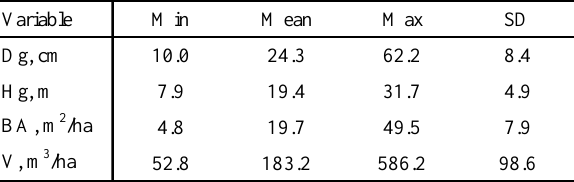
Table 1. Statistical characteristics of the field measurements (322 circular plots).